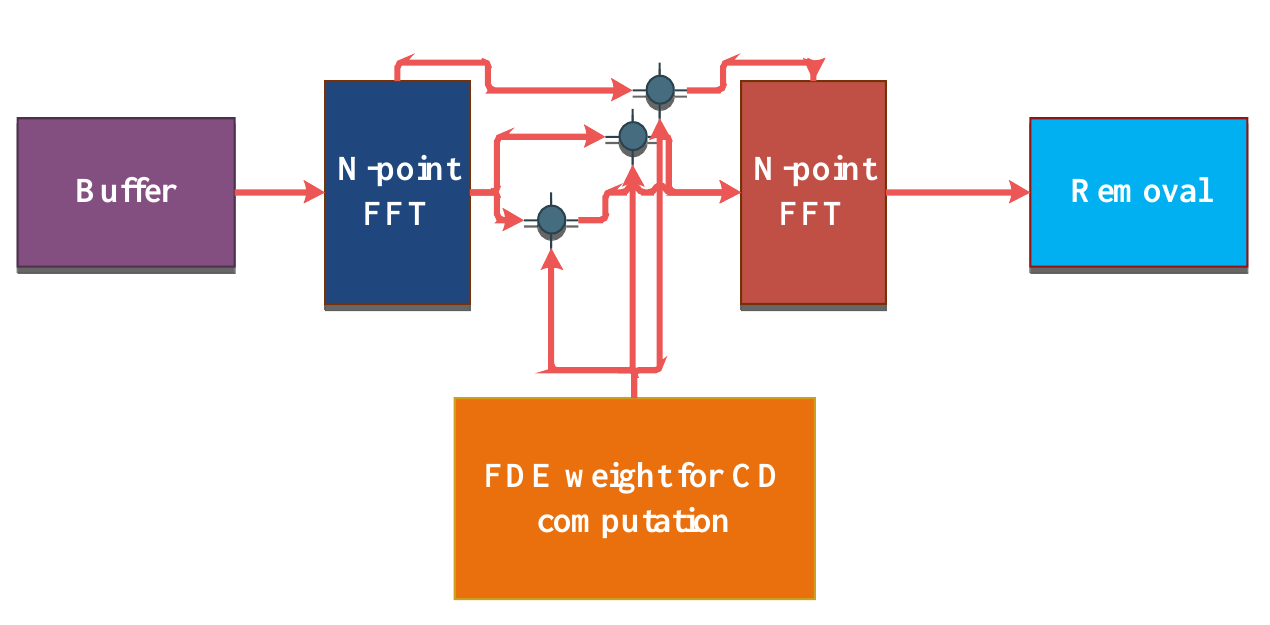
Figure 2. The proposed overlap frequency domain equalization (OFDE) structure.